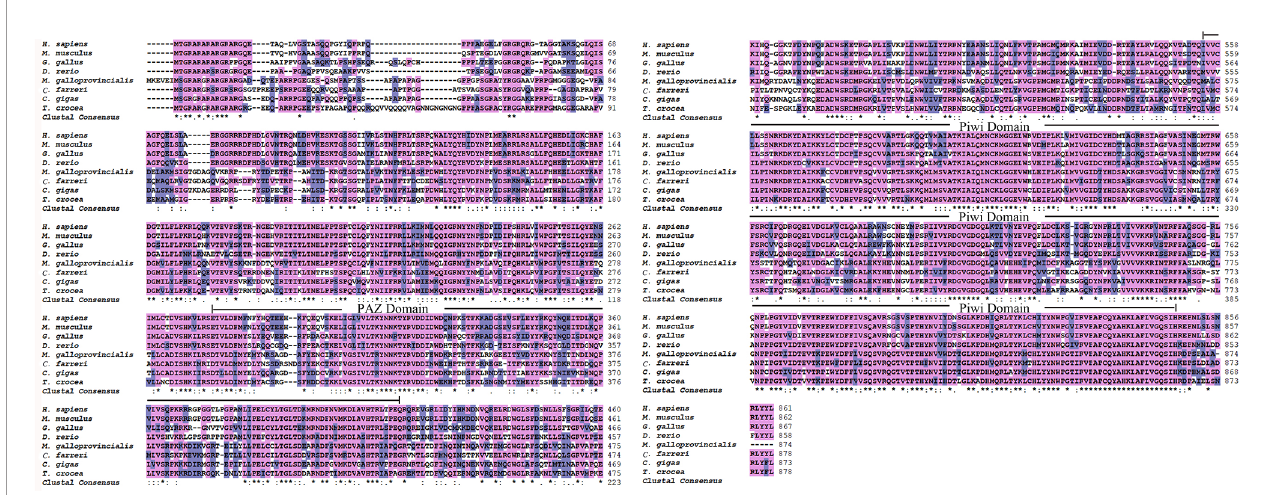
FIGURE 1 | Multiple sequence alignment of Piwi1 proteins. The PAZ and Piwi domain are marked with a continuous line. The identical and similar sequences are highlighted in purple and gray, respectively. The accession numbers for the analyzed sequences are as follows: H. sapiens (NP 004755.2), M. musculus (NP067286.1), G. gallus (NP001092322.1), D. rerio (AAL57170.1), M. galloprovincialis (AMN88361.1), C. farreri (ALK82294.1), and C. gigas (XP 034338428.1) ‘ * ’ indicates positions which have a single, fully conserved residue; ‘ : ’ represent a similar amino acid residue